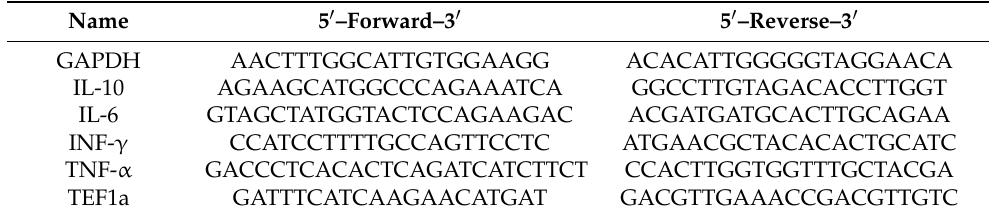
Table 1. Primer sequences of the amplified